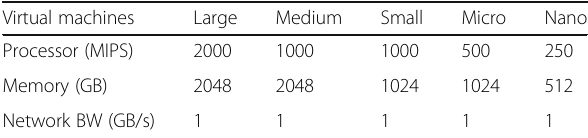
Table 2 Characteristics of Virtual Machines (VMs) Virtual machines